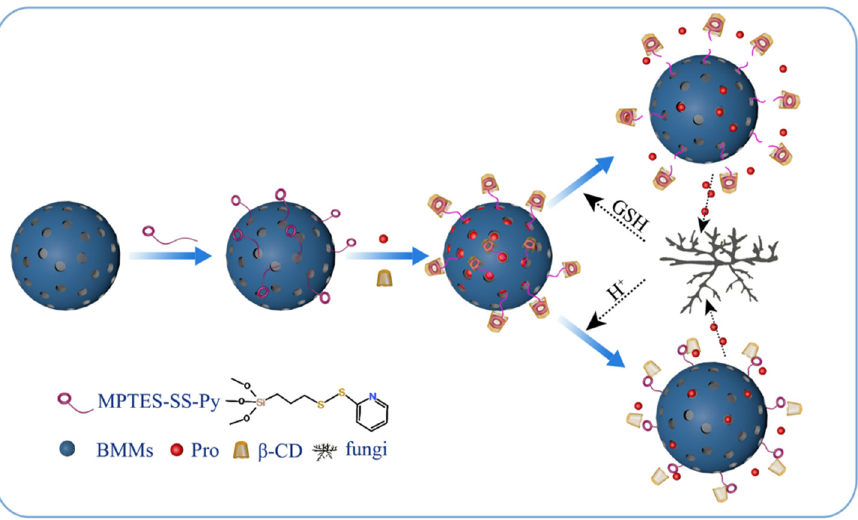
Figure 1. Schematic diagram for preparation of Pro@BMMs-SS-Py/ β -CD nanoparticles and their dual-responsive release mechanism.